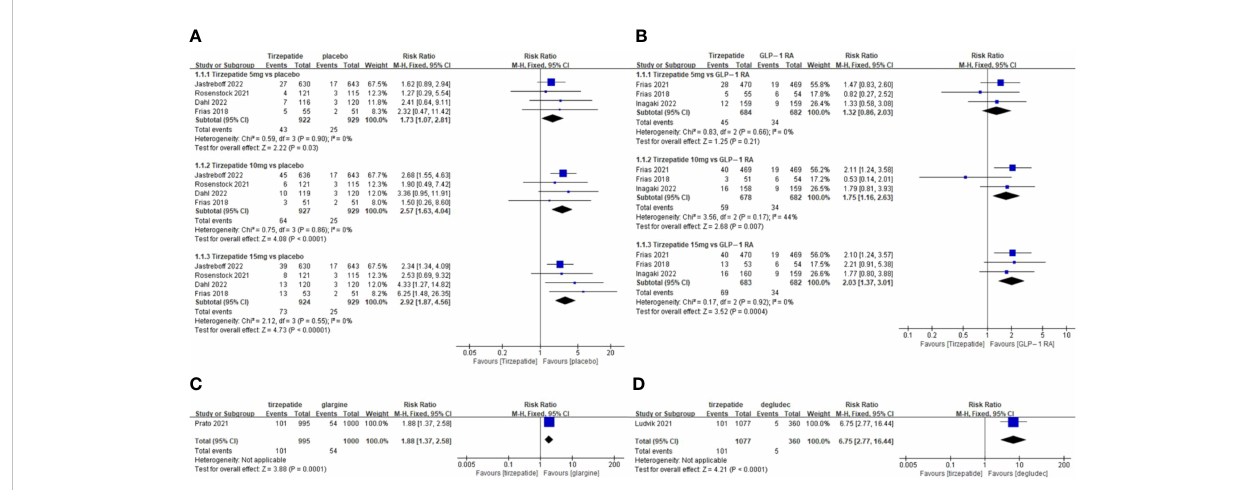
FIGURE 4 Meta-analysis results for tirzepatide of discontinuation by adverse drug event: (A) tirzepatide vs placebo. (B) tirzepatide vs GLP-1RAs. (C) tirzepatide vs insulin glargine. (D) tirzepatide vs insulin